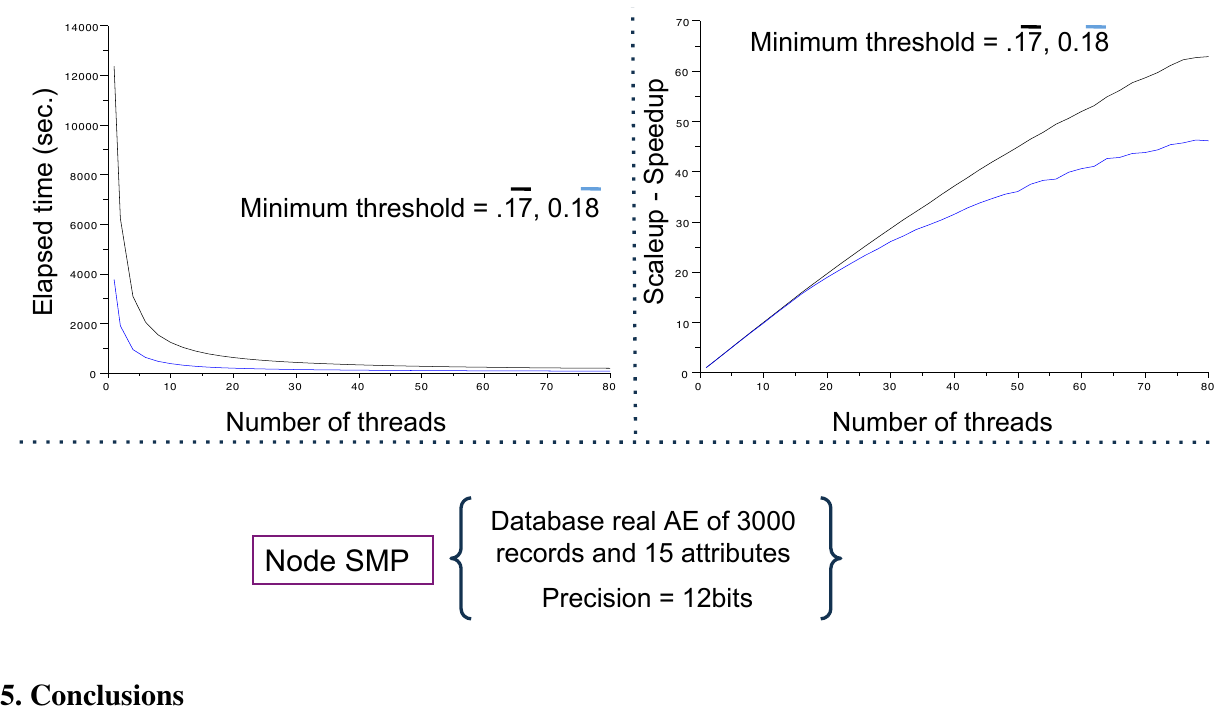
Figure 13. Execution time, Speedup and Scaleup related to the number of threads on SMP nodes for real database of 3000 lines at precision 12 bits with minimum threshold values 0.17 and